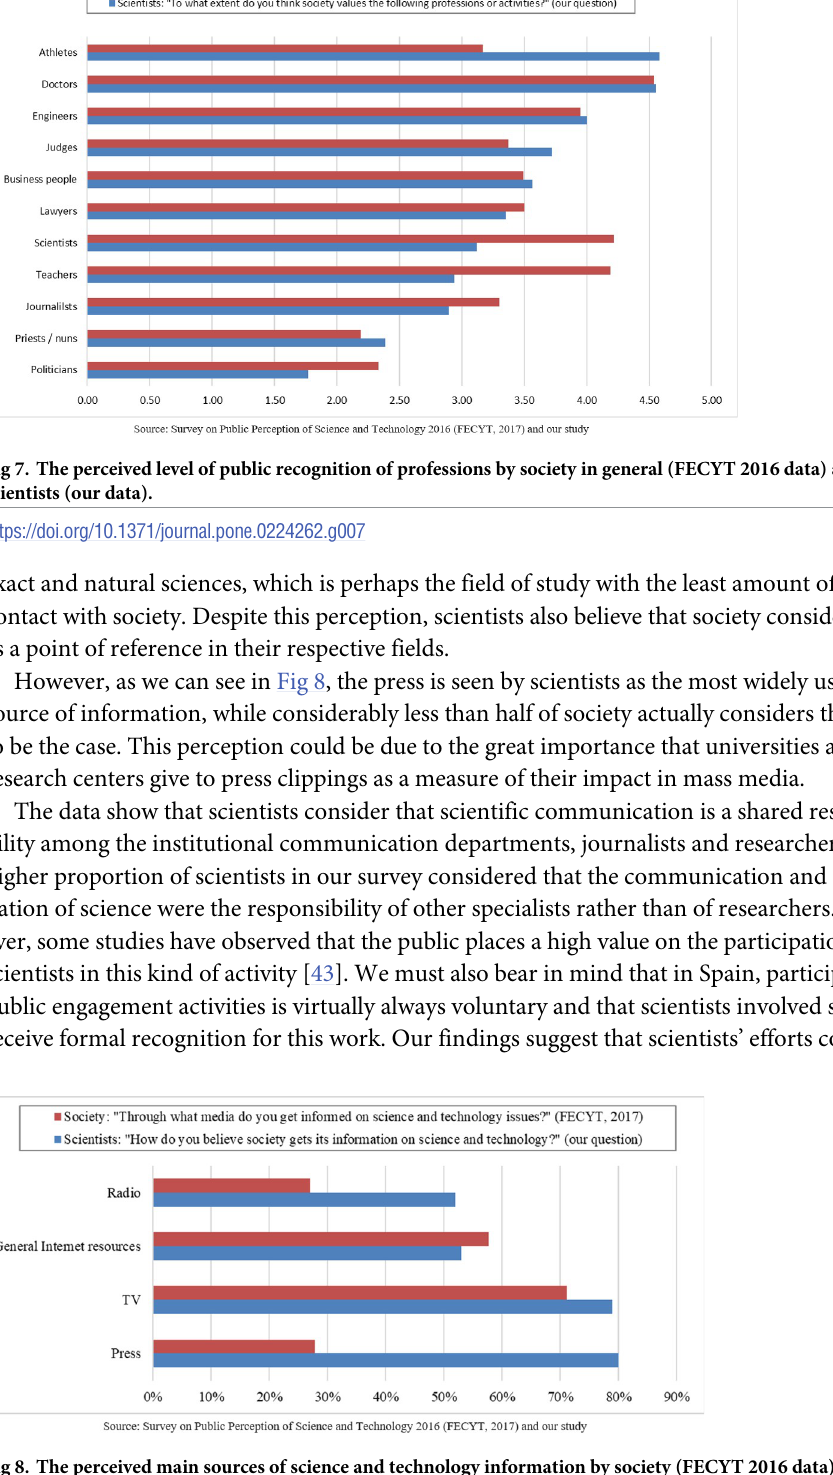
Fig 8. The perceived main sources of science and technology information by society (FECYT 2016 data) and by scientists (our data).